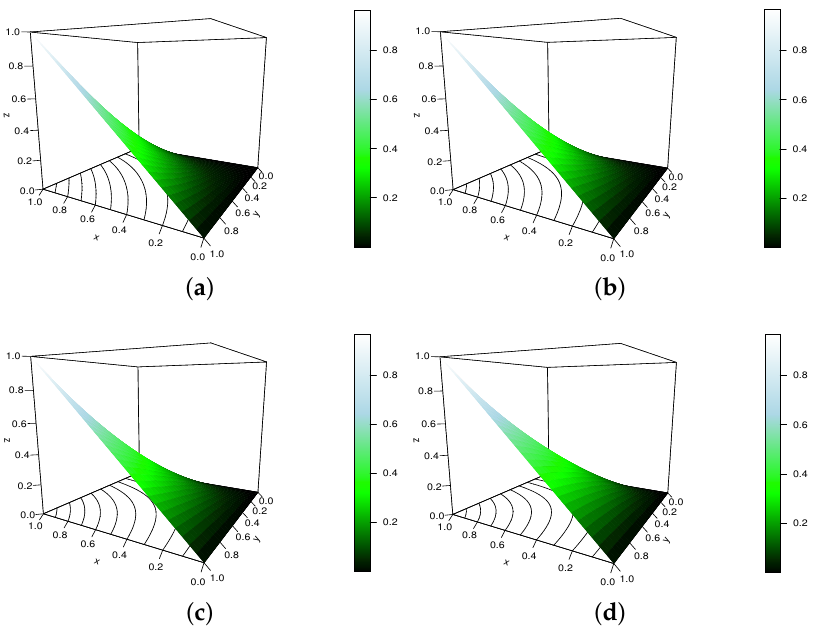
Figure 7. Display of the HAS copula for β = 1, γ = 1, and ( a ) α = − 0.8, ( b ) α = − 0.2, ( c ) α = 0.2 and ( d ) α = 0.8.